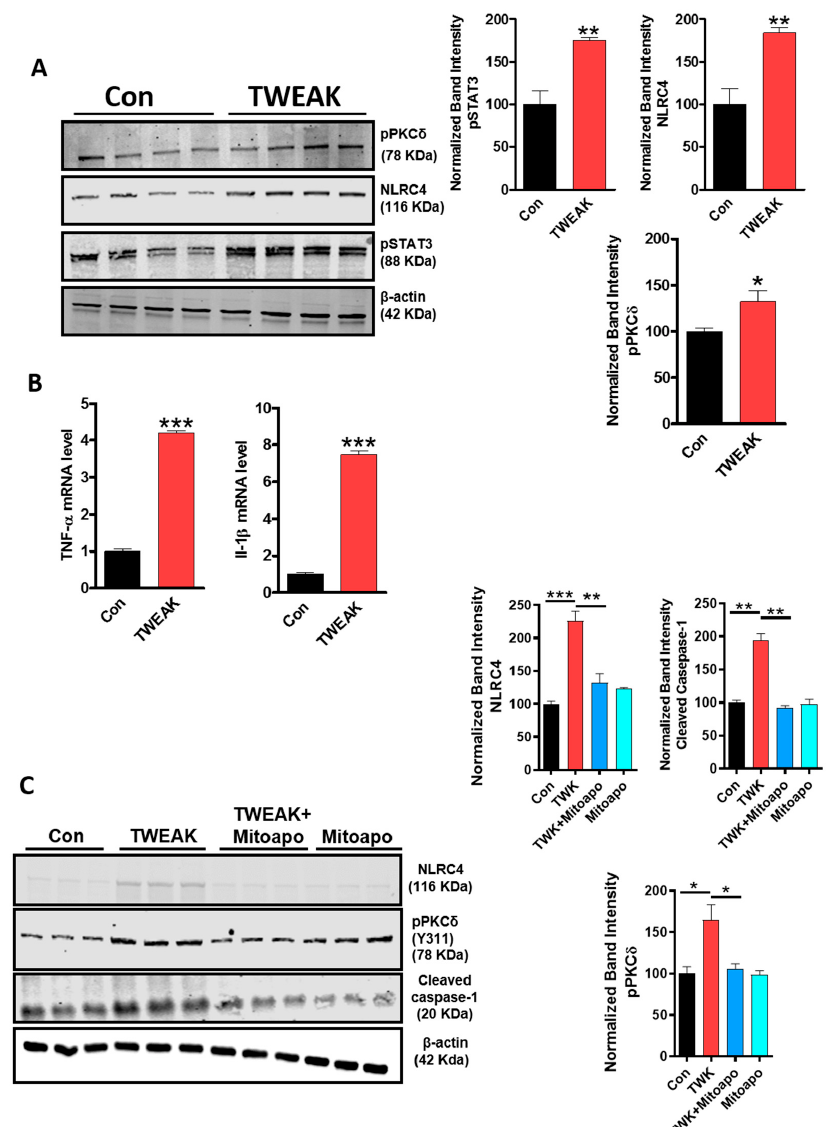
Figure 3. The NLRC4 inflammasome and PKC δ activation positively correlate with STAT3 activation and the generation of proinflammatory cytokines in TWEAK-stimulated primary astrocytes. ( A ) Primary astrocytes were stimulated with TWEAK (100 ng/mL) for 24 h, and cell lysates were assessed for PKC δ , NLRC4 and STAT3 by immunoblotting analysis; β -actin was used as the internal loading control. Quantification of bands using densitometric scanning analysis revealed that TWEAK promoted the activation of the aforementioned inflammasome-related proinflammatory markers. Data presented as mean ± SEM and representative of four independent experiments. ( B ) Primary astrocytes were subjected to real-time quantitative PCR analysis to quantify mRNA levels of pro-inflammatory markers, namely TNF- α , IL-1 β and IL-18, at indicated time points. The normalized fold increase in gene expression over the control was calculated by the ΔΔ Ct method. Primary astrocyte cells were pretreated with mito-apocynin (10 μ M) for 1 h and analyzed for target protein expression levels 24 h post-TWEAK treatment. ( C ) Cell lysates were analyzed for pPKC δ , NLRC4 and cleaved-caspase-1 using Western blot analysis. Representative immunoblots and quantification of bands using densitometric scanning analysis are depicted. Mito-apocynin (10 µ M) pretreatment yielded a significant reduction in protein levels of NLRC4 inflammasome markers, as assessed by WB. Data are presented as the mean ± SEM and representative of four independent experiments. Data were analyzed using one-way ANOVA followed by Bonferroni’s post hoc analysis. Asterisks (*** p < 0.001, ** p < 0.01 and * p < 0.05) indicate significant di ff erences between control and treatment